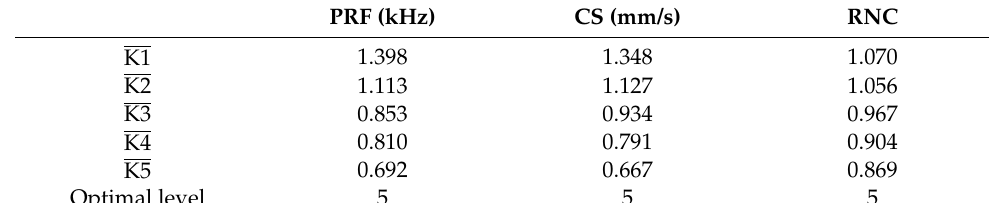
Table 5. Range analysis table based on roundness evaluation.